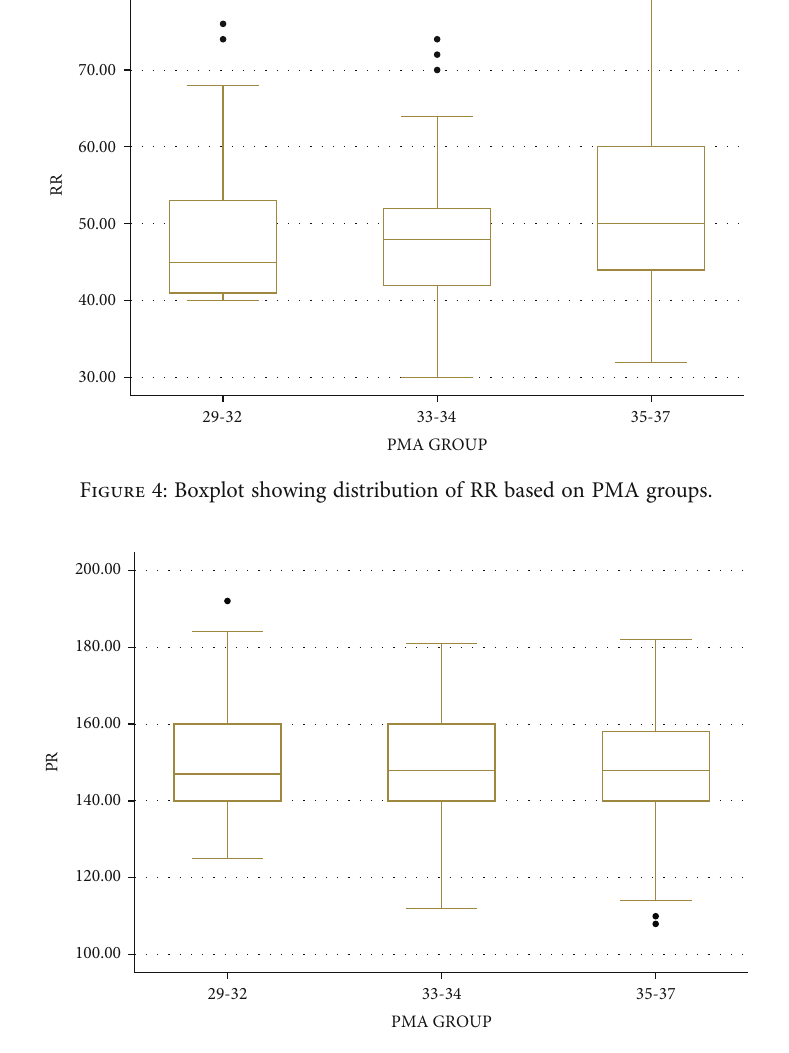
Figure 5: Boxplot showing distribution of PR based on PMA groups.